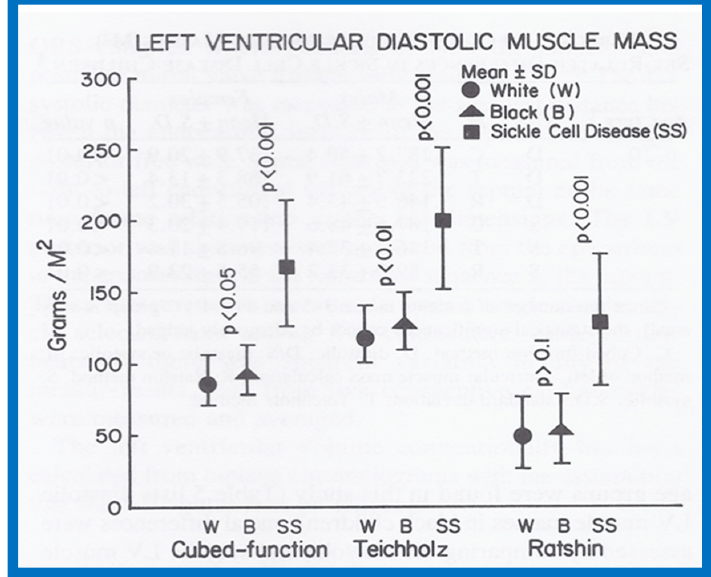
Figure 29. Left ventricular muscle mass in diastole expressed as g/M 2 is illustrated for white (filled circles) and black (filled triangles) children and sickle cell disease patients (filled squares). Means and standard deviations are shown. Note higher muscle mass in black than in white children by cubed ‐ function ( p < 0.05) and Teichholz ( p < 0.01) methods; this difference is not significant ( p > 0.10 by Ratshin’s method. The diastolic left ventricular muscle mass in sickle cell disease is increased ( p < 0.001) when compared with normal subjects by all three methods. Reproduced from Rao P.S., et al. [9].